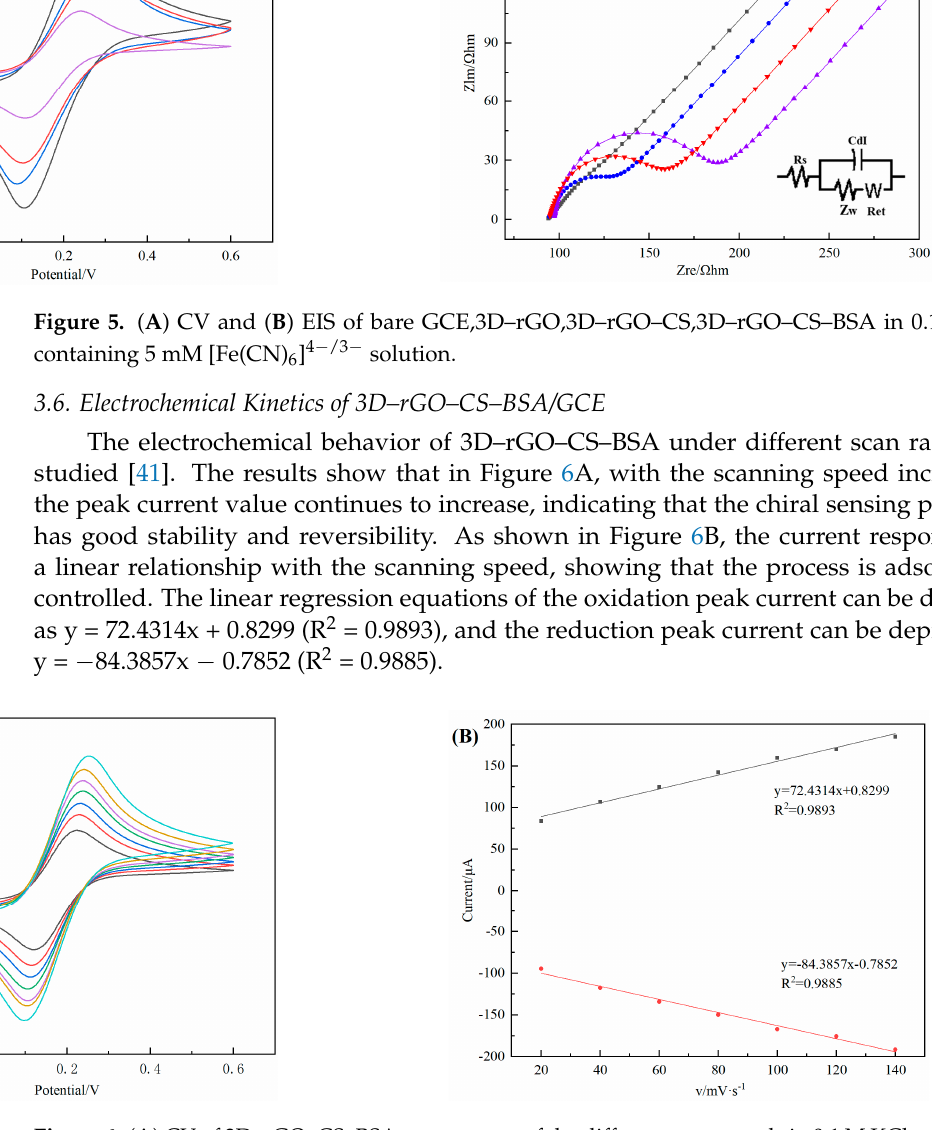
Figure 6. ( A ) CV of 3D–rGO–CS–BSA at scan rates of the di ff erent scan speeds in 0.1 M KCl contain- ing 5 mM [Fe(CN) 6 ] 4 − /3 − solution; ( B ) linear relevance between scan rate and peak current.